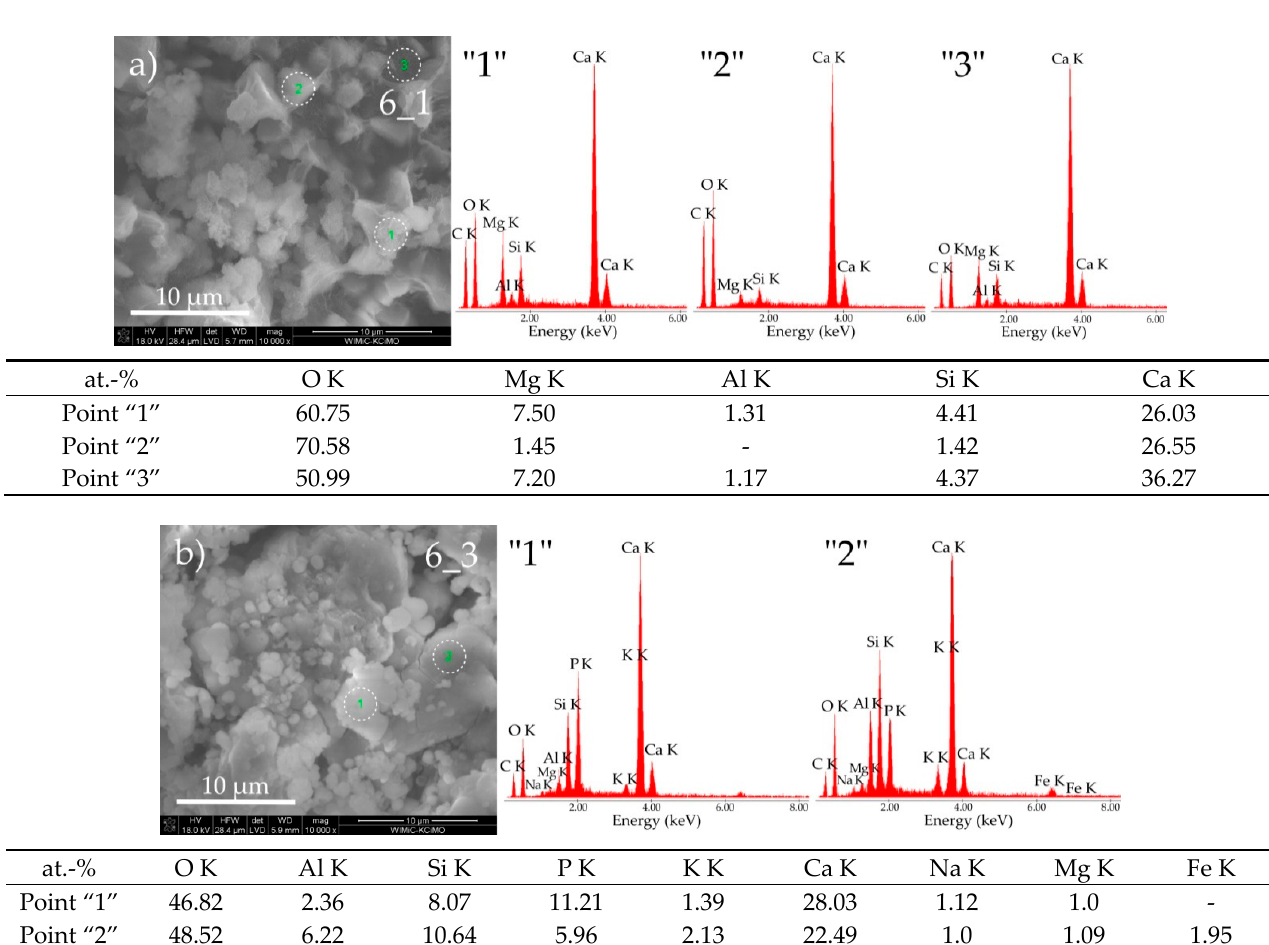
Figure 8. SEM micrographs of cement paste 6 obtained after exposure under the conditions of ( a ) water (sample 6_1) and ( b ) pig slurry (sample 6_3) with EDS quantitative point analyses from areas 1, 2, and 3.